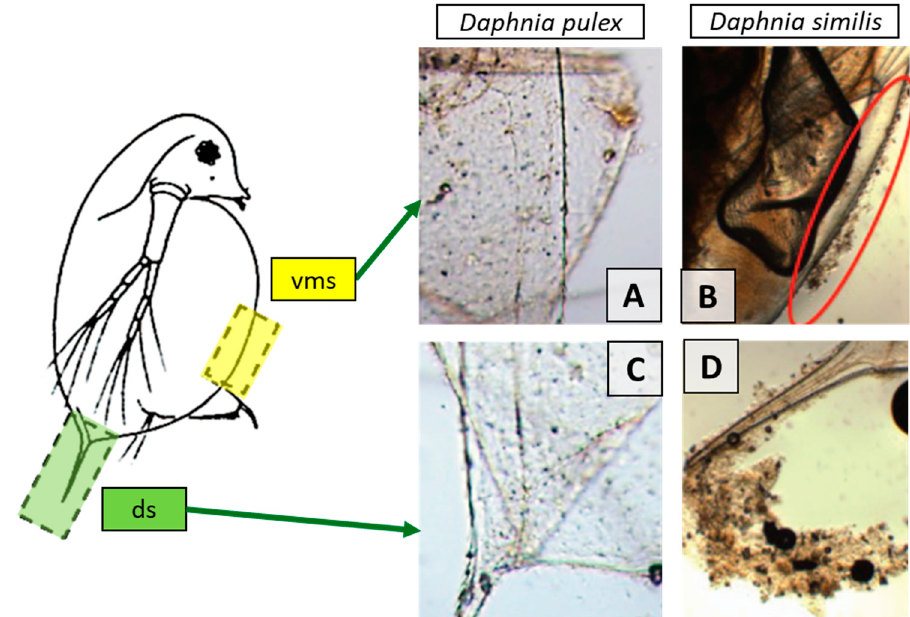
Figure 29. Representative image of distal spine (ds) and ventral margin of the shield (vms) in Daphnia pulex and D. simillis exposed to 10 mg/L of CeO2 NPs for 48 h. Note the accumulation of particles onto the cuticle of D. simillis . (Modified after [146] ).